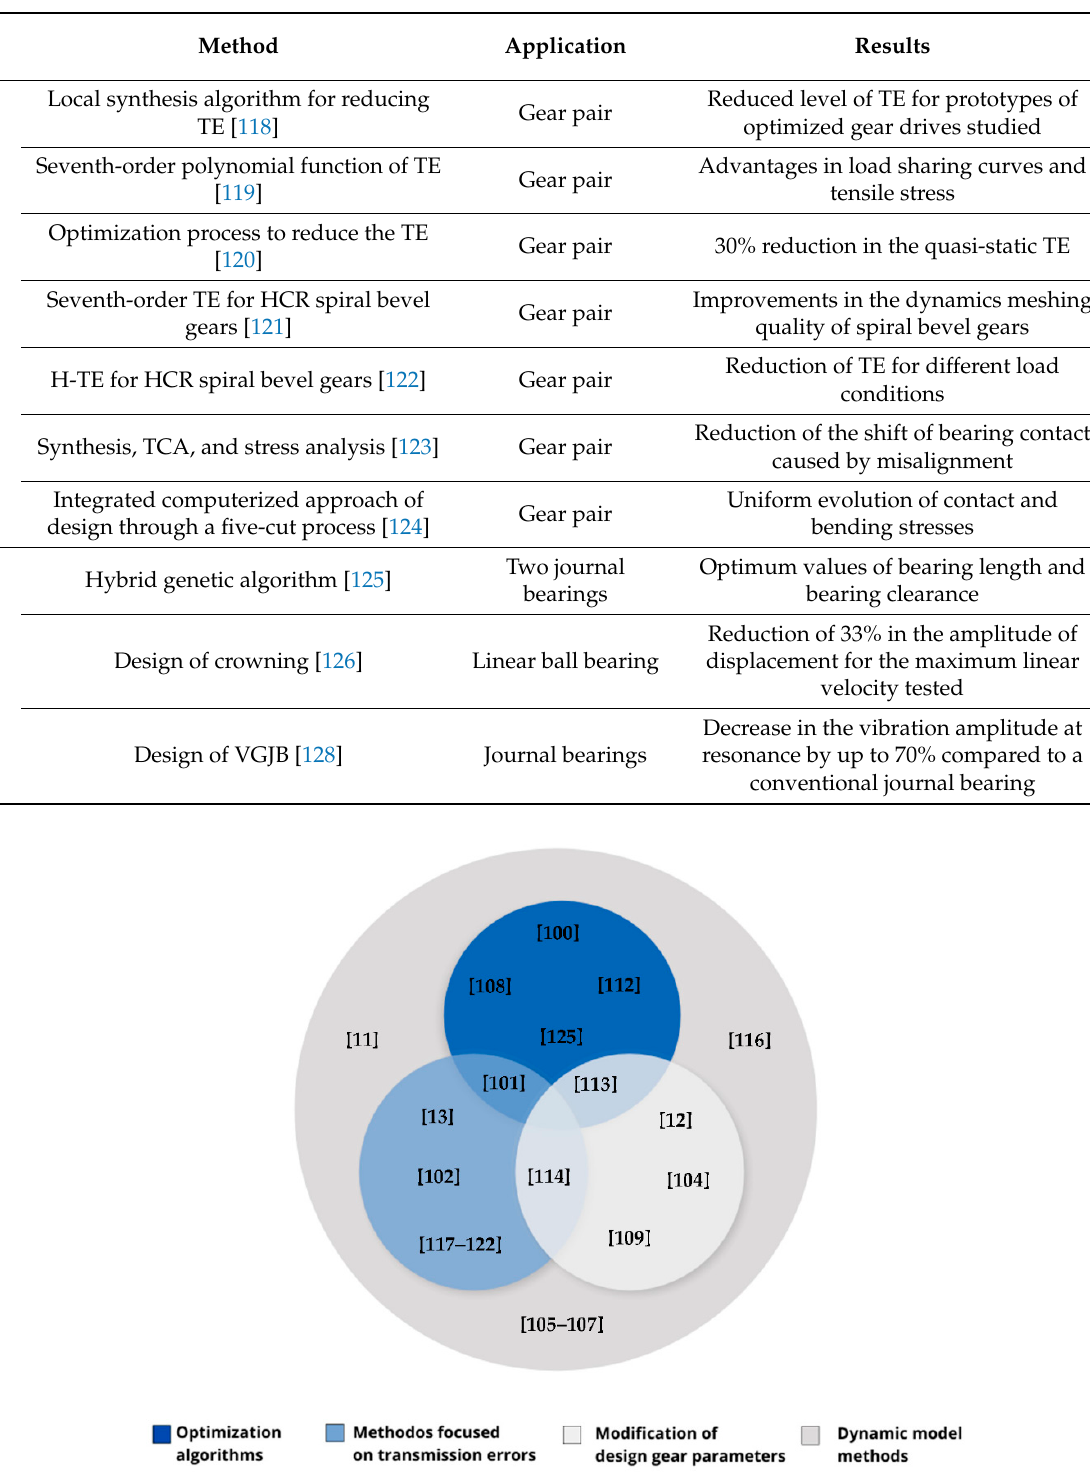
Figure 5. Principal papers found grouped by the approach used to solve the problem of minimizing vibrations from the design stage in geared